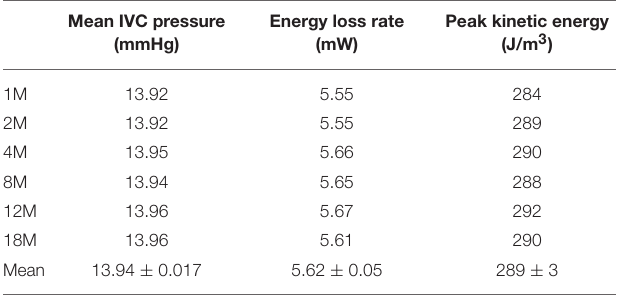
TABLE 2 | Performance of six realizations of the “physiological” Fontan, predicted on different CFD meshes.